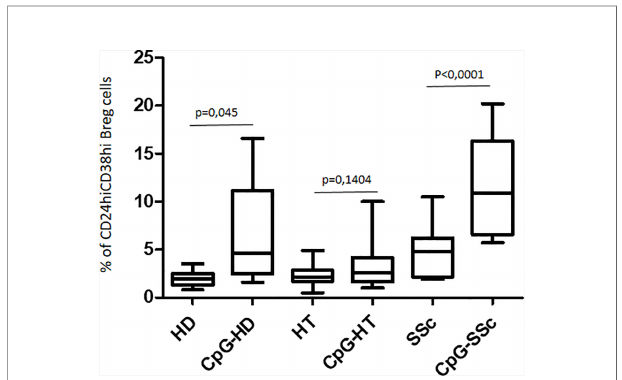
FIGURE 4 | Comparison of the effects of CpG stimulation on CD24hiCD38hi Breg cells in healthy donors (HD), in HT patients, and in patients with SSc. Paired T test has been used for single